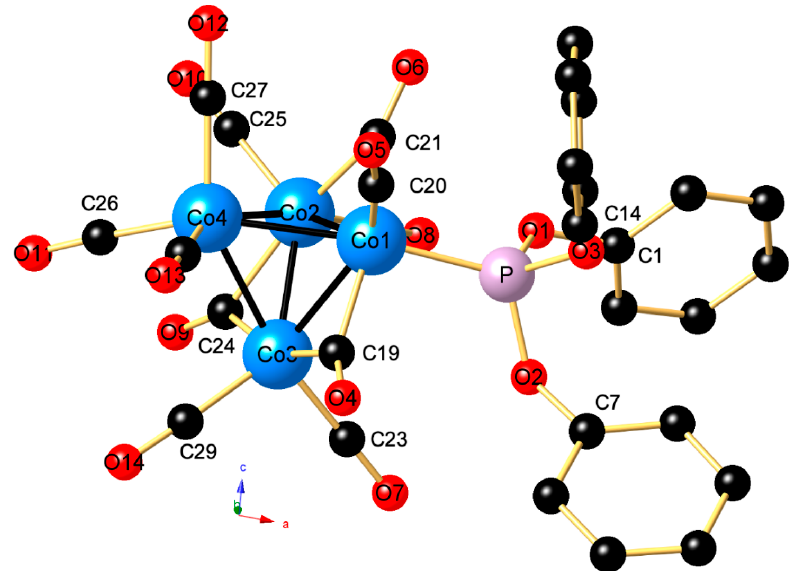
Figure 5. Molecular structure of 2 . Selected angles (deg) : For clarity’s sake, all H atoms are omitted. Co1–Co2–Co3 60.008(8), Co1–Co2–Co4 60.369(9), Co1–Co3–Co2 60.284(8), Co1–Co4–Co3 58.646(7), Co1–Co4–Co2 58.796(7), Co3–Co4–Co2 58.305(7), Co4–Co1–P 166.108(11), Co3–Co1–P 107.602(11), and Co2–Co1–P 107.385(11).